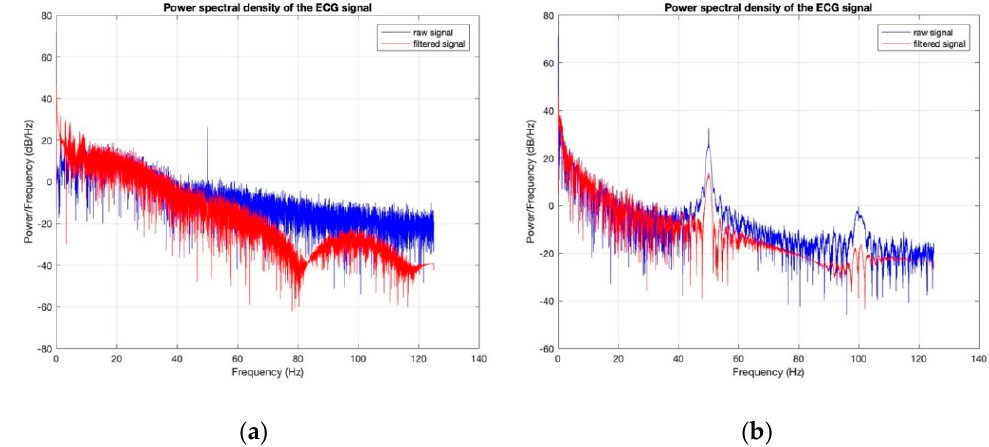
Figure 23. Power Spectral Density of ECG signal obtained by cotton/Lycra electrodes with 11.9 wt.%